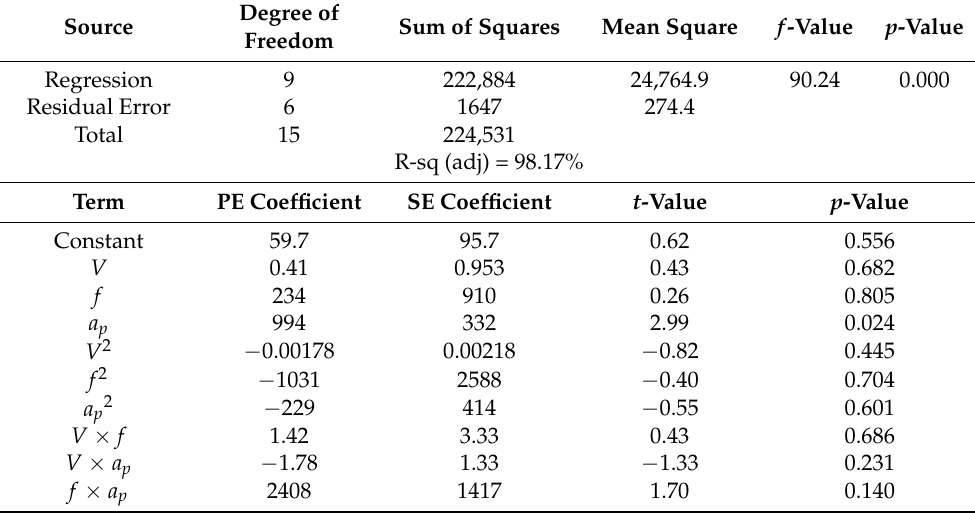
Table 6. ANOVA results for the resultant machining